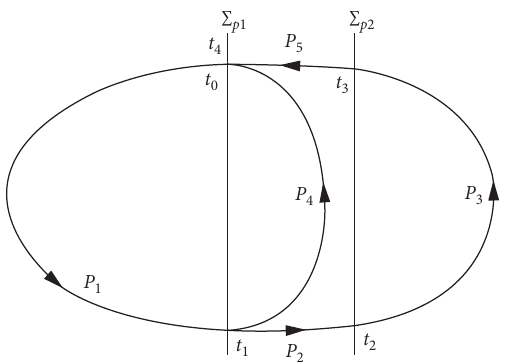
Figure 2: Schematic diagram of Poincar´e mapping of the